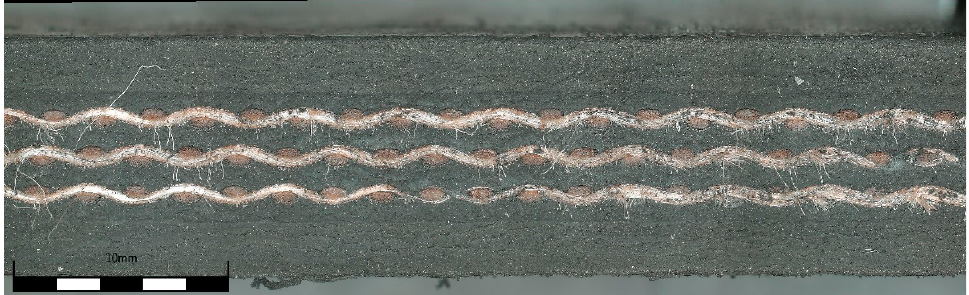
Figure 6. Side view of textile ‐ reinforced conveyor belt made at vulcanization condition of 160 °C for 35 min.